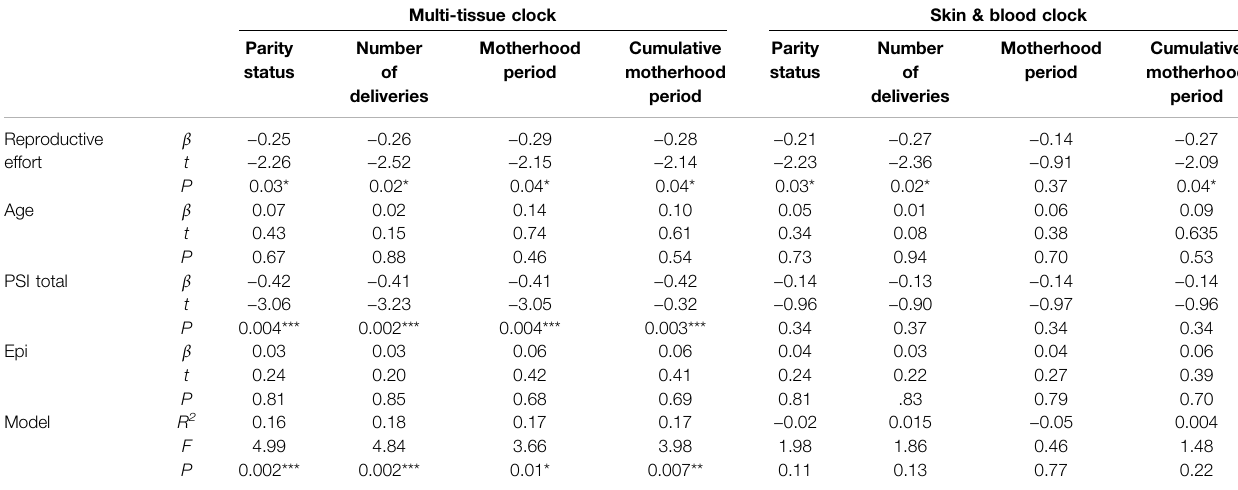
TABLE 3 | Multiple linear regression with robust standard errors for mAge accelerations.